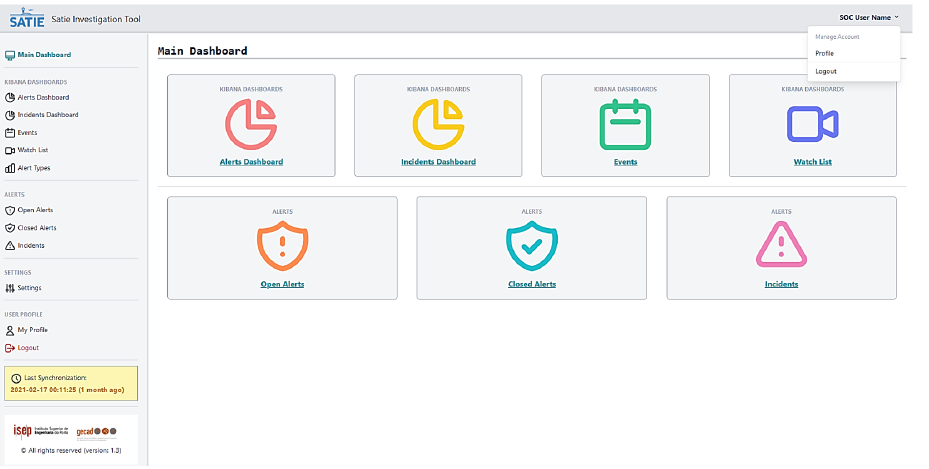
Figure 8. SMS-I Intelligent Dashboard